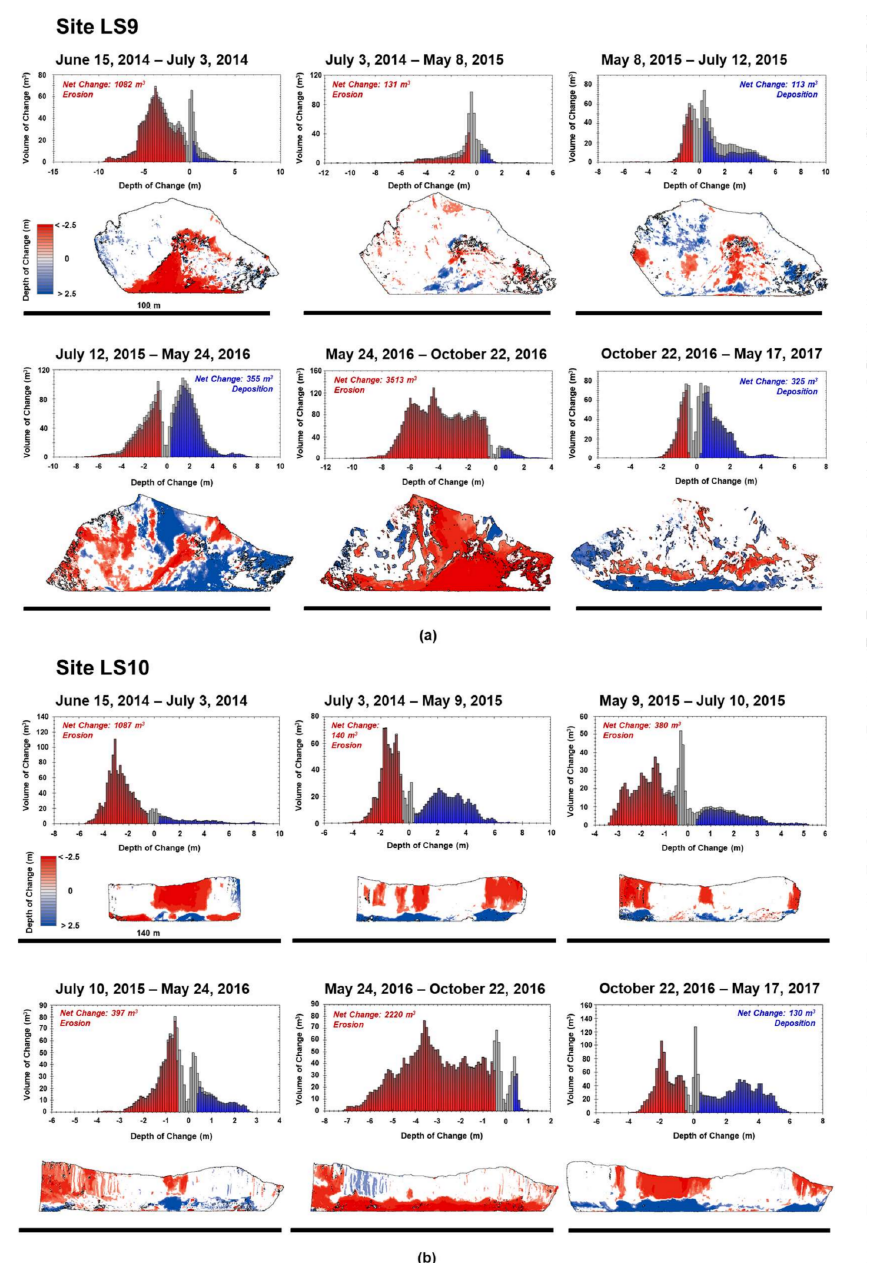
Figure 3. Panels of change from seven repeat structure-from-motion survey-generated DEMs of difference (below) and distributions of volumetric change (m 3 ) as a function of depth of change (m) (above) for site LS9 ( a ) and LS10 ( b ); outputs from ArcMap 10.4, Geomorphic Change Detection software 5.0. All survey areas are plotted relative to the same black bar indicating approximately the maximum length of each bluff surveyed. Bluff geomorphic change surveys shown perpendicular to the streamwise direction; flow direction from left to right for site LS9, and right to left for site